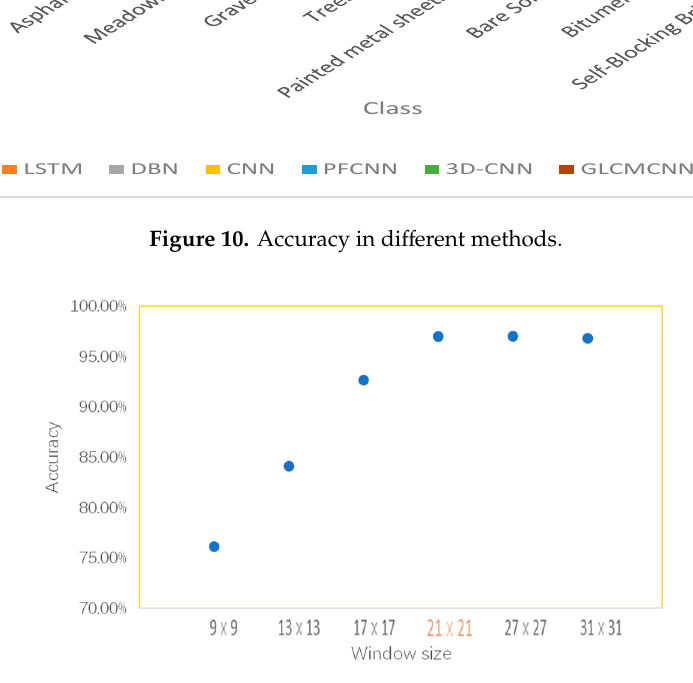
Figure 12. Indian pines dataset OA changes with the training set selection ratio.